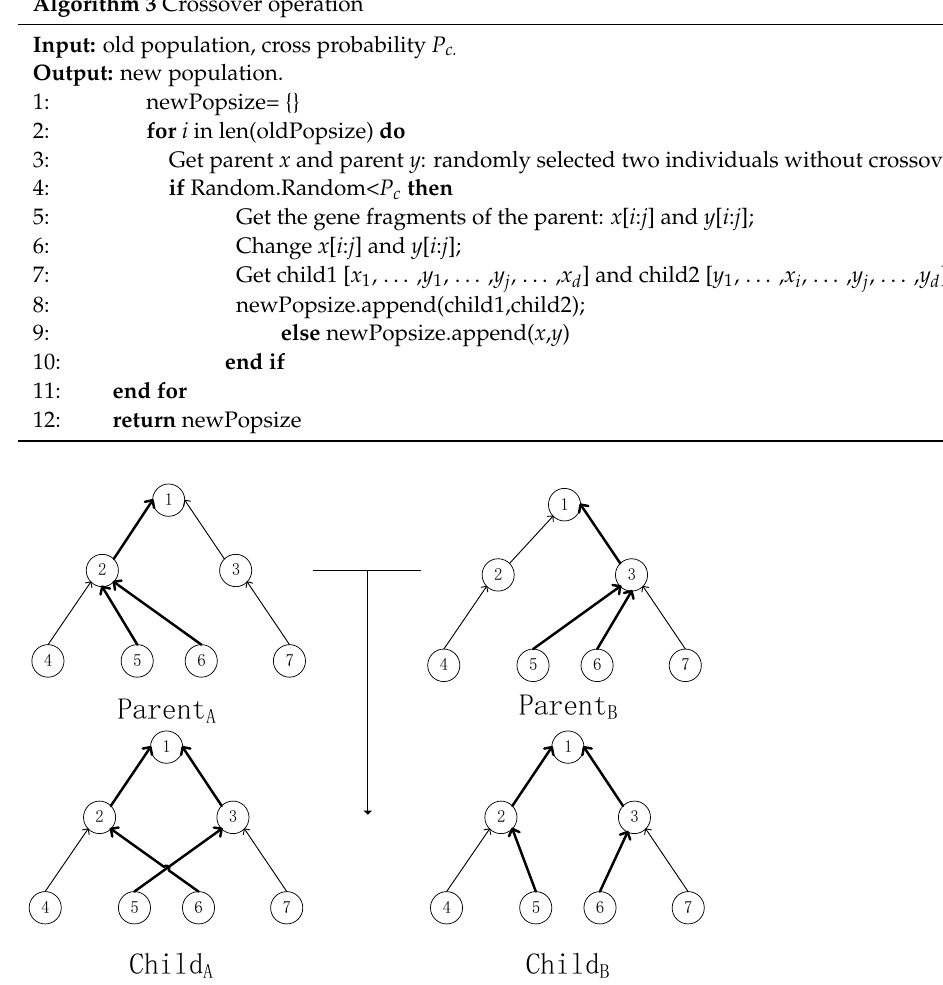
Algorithm 3 Crossover operation